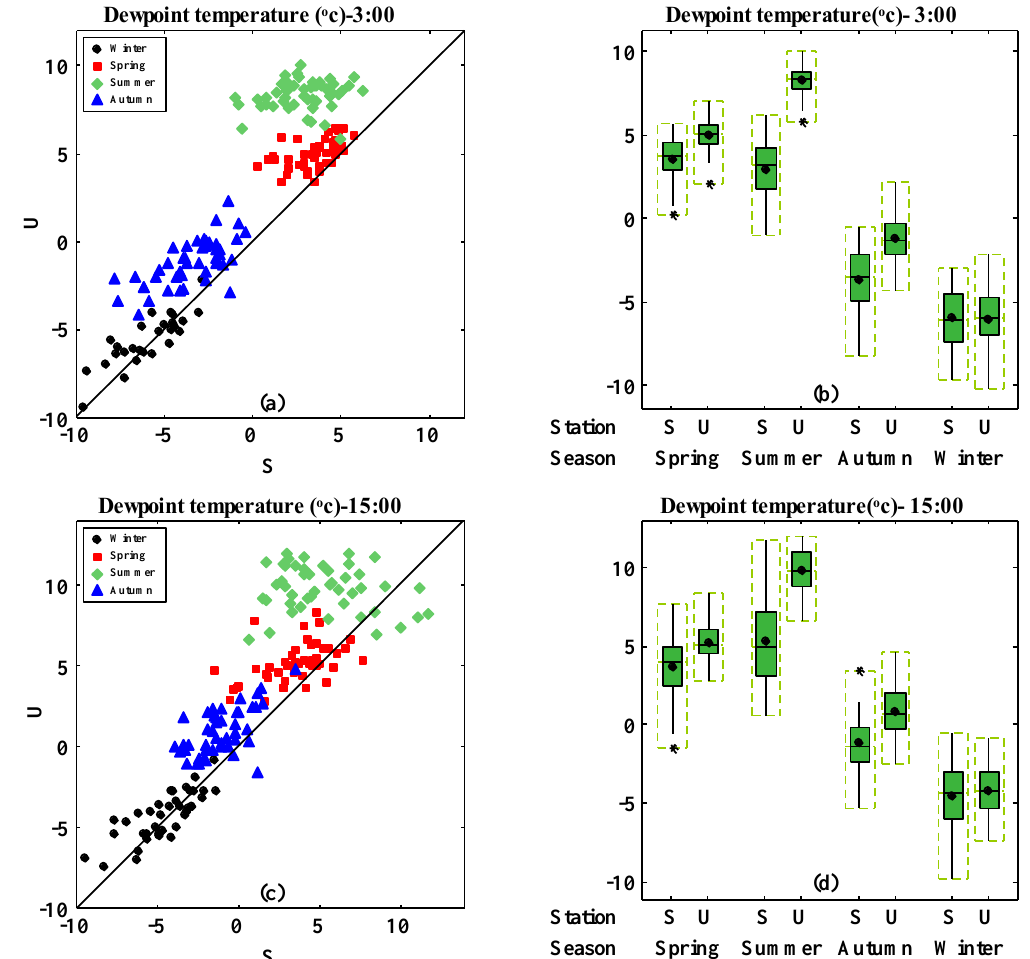
Figure 7. Seasonal pattern in dewpoint temperature. Scatterplots of dewpoint temperature at ( a ) 03:00 h and ( c ) 15.00 h in the di ff erent seasons at Urmia station (U) and Saqez station (S). ( b , d ) The corresponding boxplots.